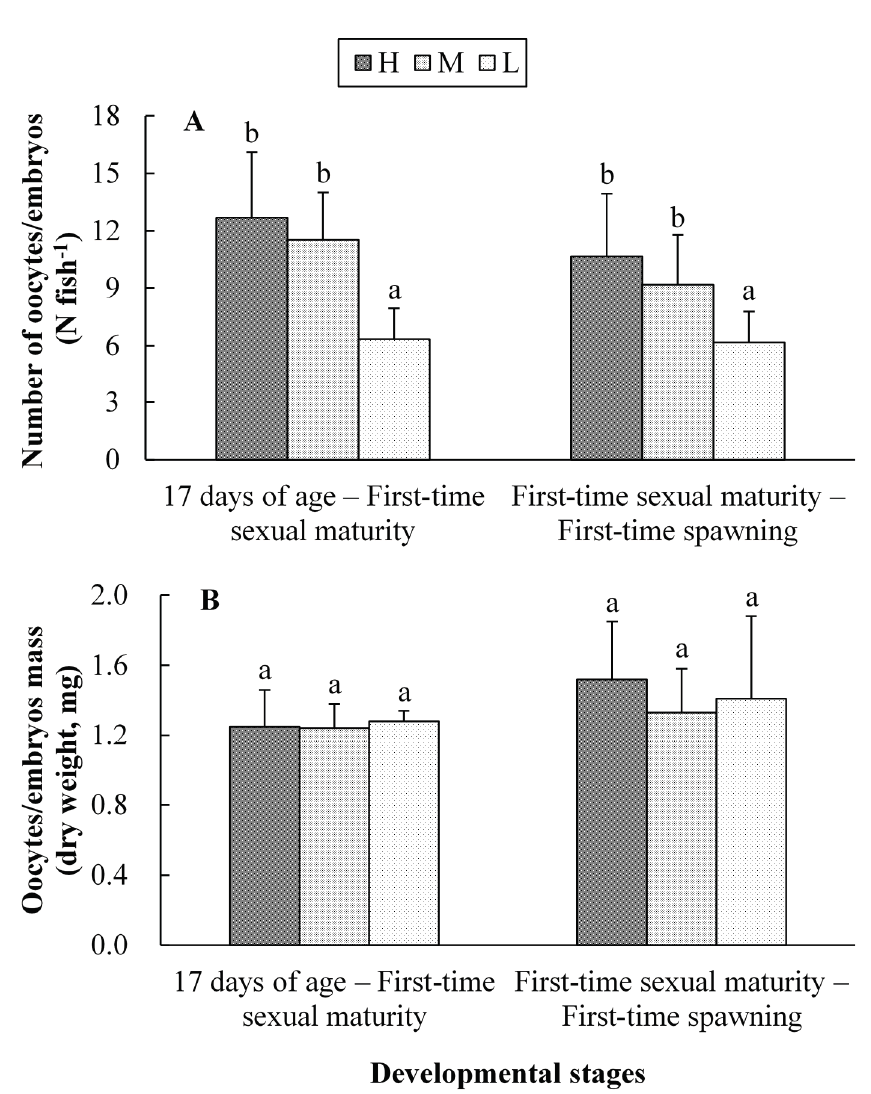
Figure 2. The number ( A ) and weight ( B ) of oocytes (for 17 days of age—First-time sexual maturity stage) or embryos (for First-time sexual maturity—First-time spawning stage) for female G. affinis at first-time reproduction in the three ration levels during different developmental stages . Different superscripts within the same developmental stage represent significant difference (one-way ANOVA, p <